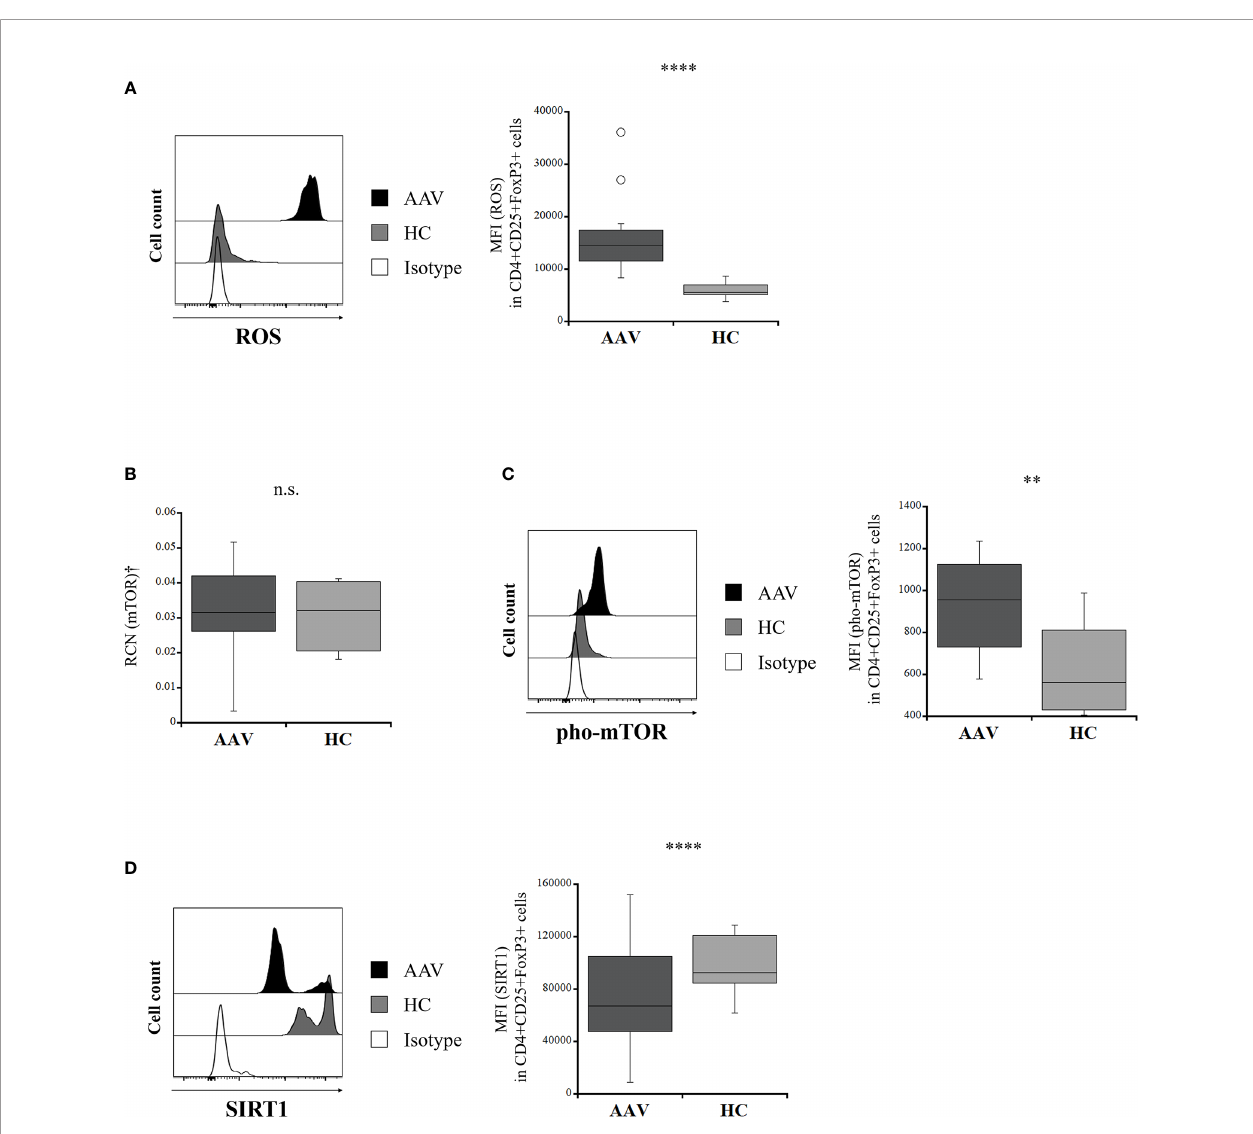
FIGURE 2 | Comparison of intracellular mediators in regulatory T cells between the patients with ANCA-associated vasculitis (AAV) and healthy controls (HC). (A) representative histogram showing expression of reactive oxygen species (ROS) in CD4+CD25+FoxP3+ cells (left). The median fl uorescence index (MFI) of ROS in CD4+CD25+FoxP3+ cells (AAV, n = 20; HC, n = 13) (right). (B) relative copy number (RCN) of mammalian target of rapamycin (mTOR) in isolated Tregs (AAV, n = 10; HC, n = 7). (C) representative histogram showing expression of phosphorylated mTOR (pho-mTOR) in CD4+CD25+FoxP3+ cells (left). MFI of pho-mTOR in CD4 +CD25+FoxP3+ cells (AAV, n = 18; HC, n = 12) (right). (D) representative histogram showing expression of sirtuin 1 (SIRT1) in CD4+CD25+FoxP3+ cells (left). MFI of SIRT1 in CD4+CD25+FoxP3+ cells (AAV, n = 23; HC, n = 14) (right). † Isolated Tregs from peripheral blood mononuclear cells. n.s., not signi fi cant; ** p < 0.005; **** p <